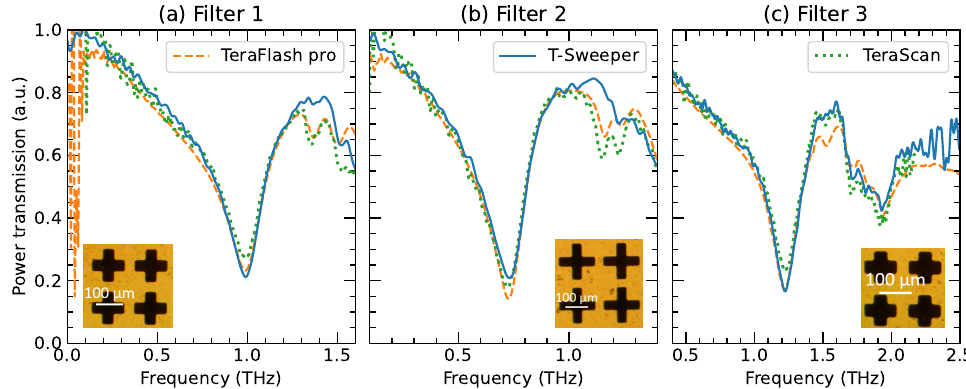
Figure 6. Measured transmission spectra of three resonant mesh filters, using all three instruments. The filter notch frequency is around 0.99THz for Filter 1, 0.73THz for Filter 2, and 1.22THz for Filter 3. Insets show microscope images of each filter, showing the differences in mesh dimensions.